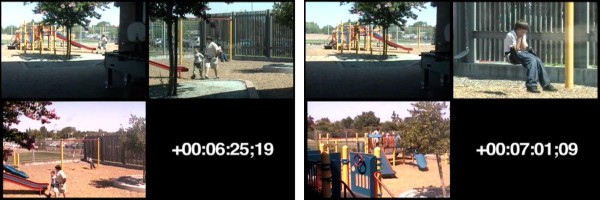
Peer interaction playground video. Three different points of view of the scene were recorded, synchronized into a uniform format and used to code the social transaction.